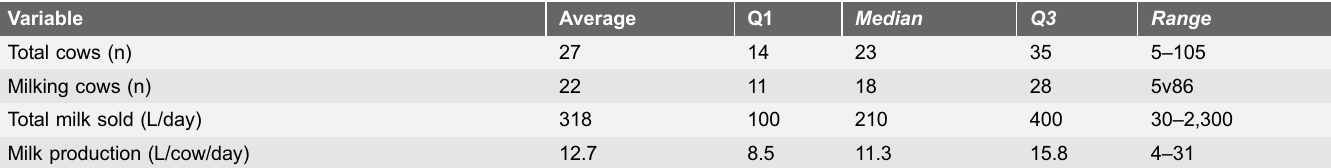
Table 1. Herd characteristics of dairy farms surveyed in the state of Santa Catarina, Brazil (n 5 242). Variable